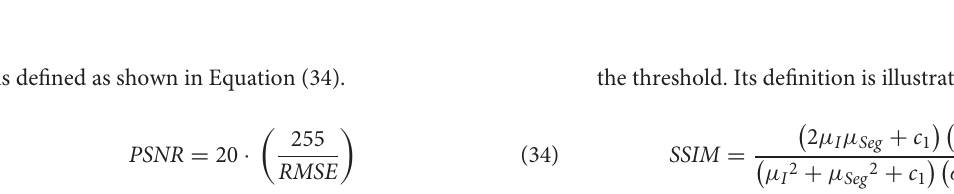
It is defined as shown in Equation